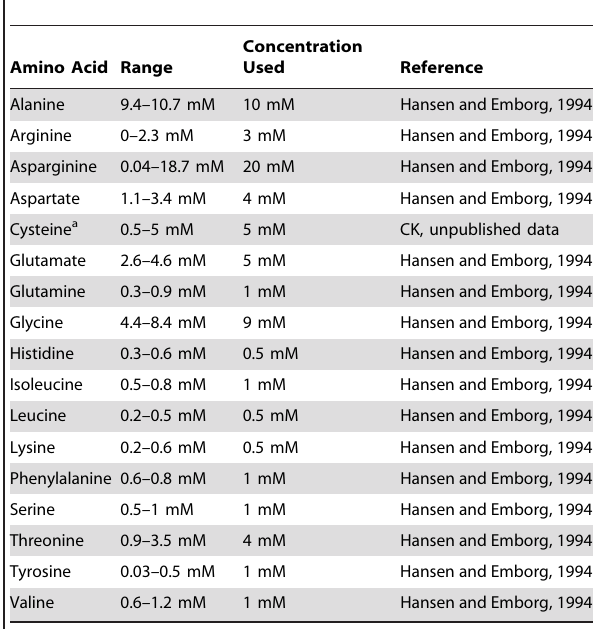
Table 1. Concentrations of amino acids used in the competition